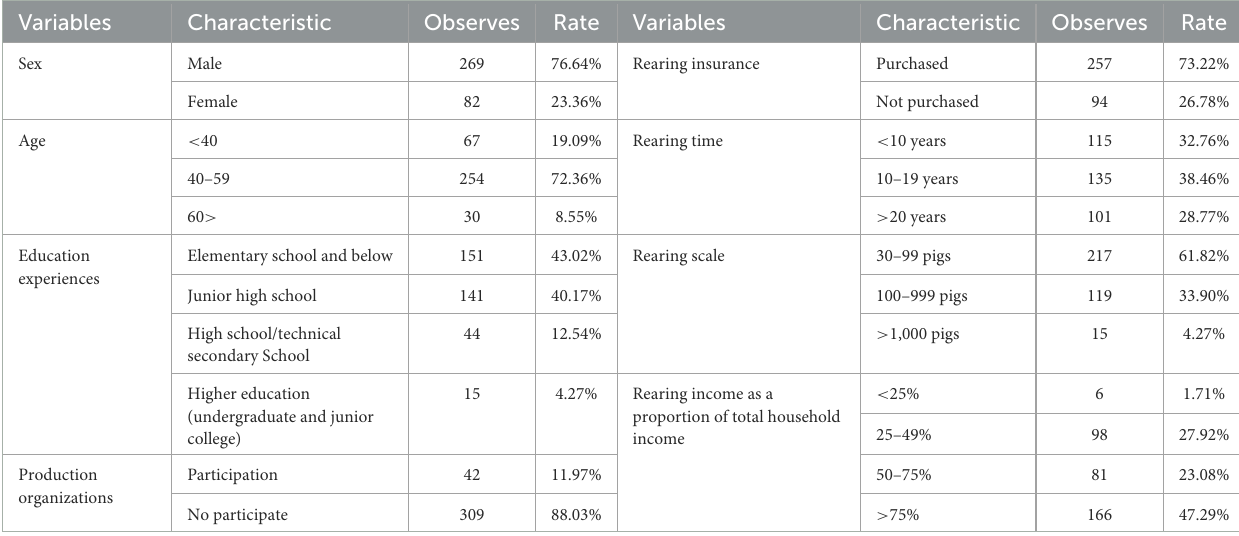
TABLE 1 Basic information about sample